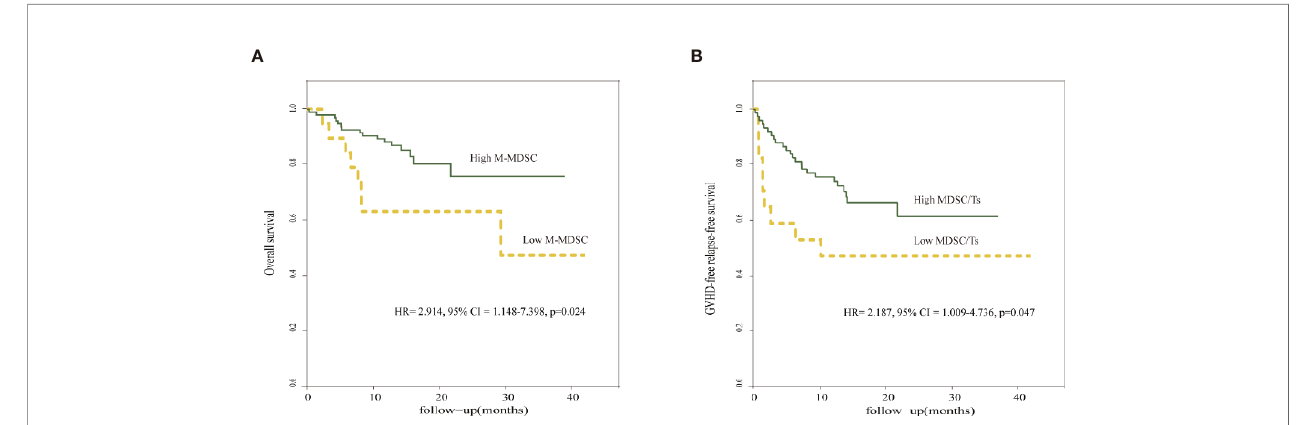
FIGURE 4 | Prognostic factors in multivariate Cox model. (A) Comparison of overall survival in relation to M-MDSC. (B) Comparison of GRFS in relation to